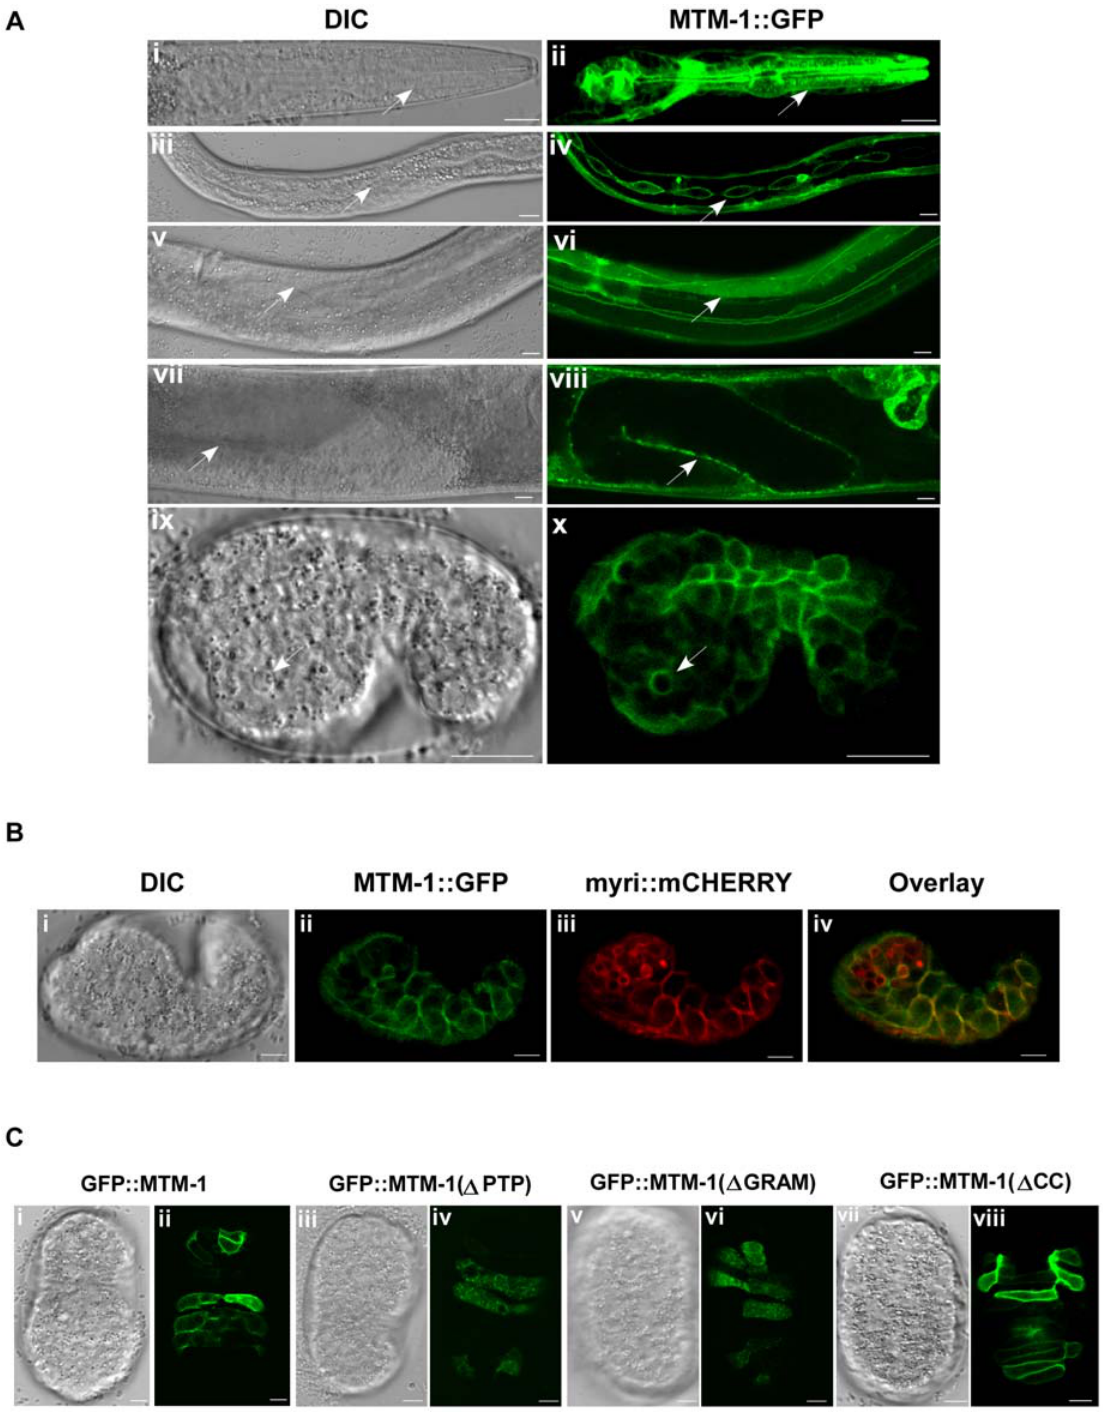
Figure 6. MTM-1 is expressed in engulfing cells and localizes to the plasma membrane. DIC and fluorescent confocal images of wild-type animals carrying an integrated array of P mtm-1 MTM-1::GFP are shown. MTM-1 is expressed in several known engulfing cell types including pharyngeal muscle cells (i, ii), hypodermal cells (iii, iv), body wall muscle cells (v, vi) and sheath cells (vii, viii) as indicated by arrows and is mainly localized to cell membranes. MTM-1::GFP also clusters around apoptotic cells (ix, x). Bars: 10 m m. (B) DIC (i), GFP (ii), mCHERRY (iii) images and the merged image of GFP and mCHERRY (iv) of a wild-type embryo co-expressing MTM-1::GFP driven by mtm-1 promoter (P mtm-1 mtm-1::gfp ) and myri::mCHERRY controlled by heat-shock promoters (P hsp myri::mcherry ) are shown. MTM-1::GFP co-localized with myri::mCHERRY to plasma membranes. Bars: 5 m m. (C) The PH- GRAM and PTP domains of MTM-1 are required for membrane localization of MTM-1. DIC and fluorescent confocal images of full-length (i, ii) and truncated GFP::MTM-1 (iii–viii) controlled by the ced-1 promoter in wild-type embryos are shown. Membrane localization was clearly seen with full- length MTM-1 (i, ii) and MTM-1( D CC) (vii, viii), but not in embryos expressing GFP::MTM-1 lacking either the PTP domain (iii, iv) or the PH-GRAM domain (v, vi). Bars: 5 m m.